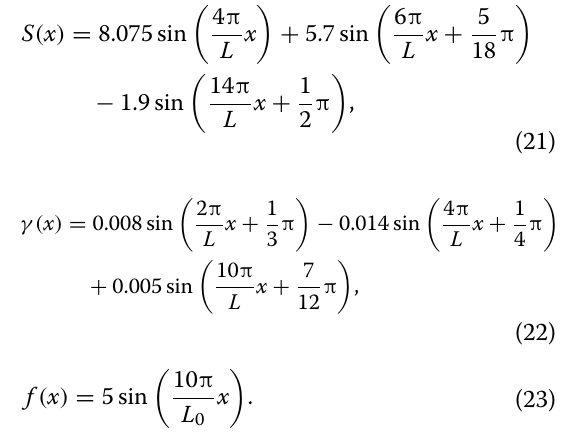
and minimum curves have the similar shape to the input curve. The curve in Figure 3(d) is obtained, as Eq. (14) is solved by using the least squares method under the condition of σ 0.1 μm. There is a significant deviation, = indicating that the least squares method is unsuitable to solve the linear system with the ill-conditioned coef- ficient matrix. The similar conclusions can be drawn for γ ( x ) from the simulation results in Figure 4.